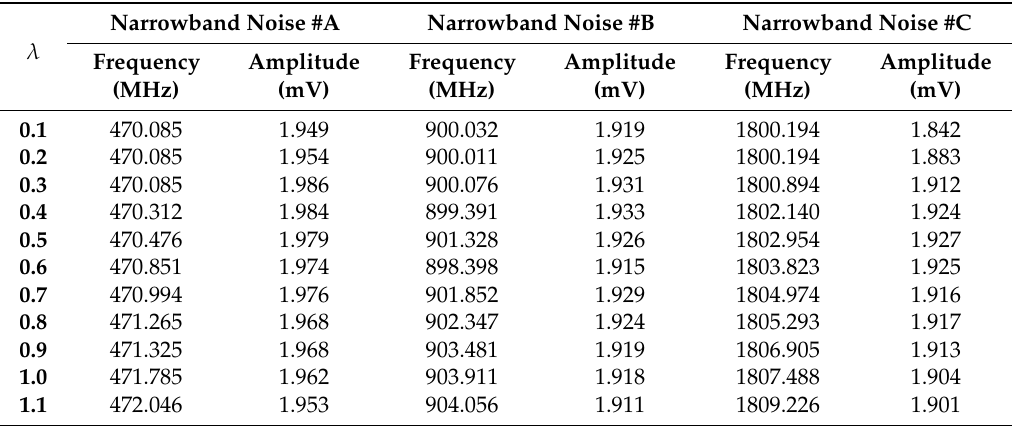
Table 2. Calculated amplitudes and frequencies with changing values of λ